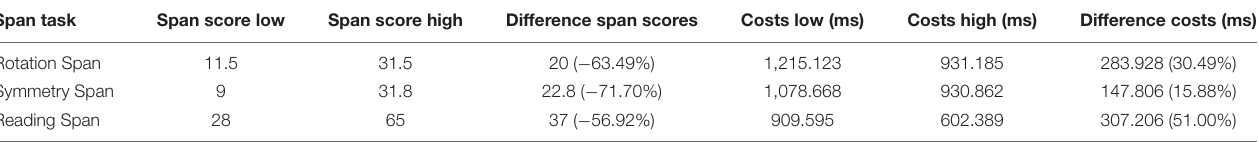
TABLE 6 | Illustration of the effect sizes in Experiment Series 2. Span task Span score low Span score high Difference span scores Costs low